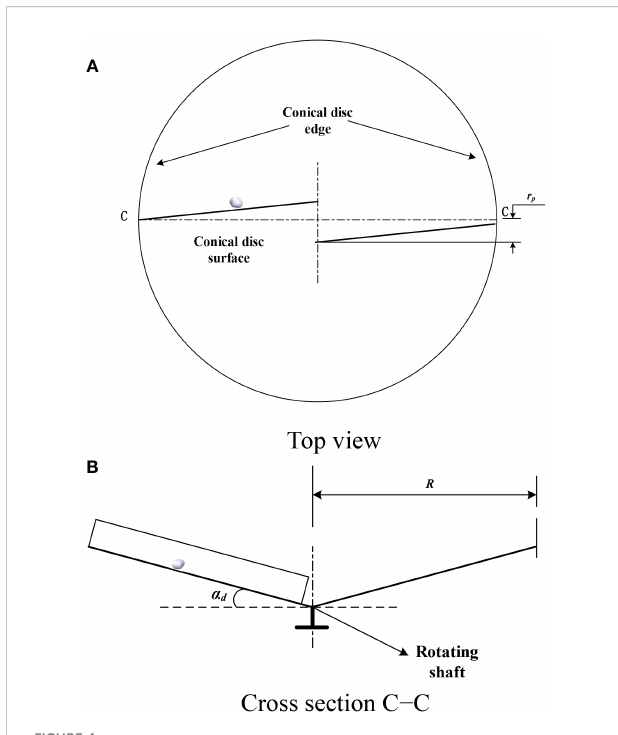
FIGURE 4 Schematic diagram of conical impeller disk. (A) Top view (B) Cross section C − C.